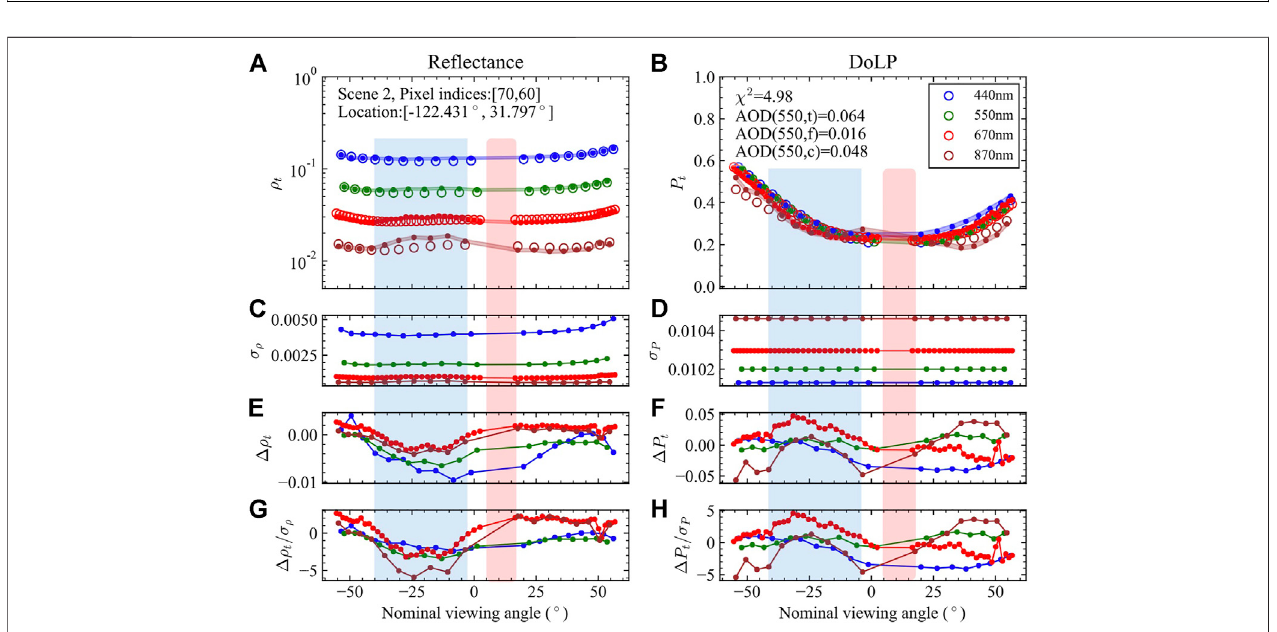
FIGURE7|(A,B) Fitted re fl ectance and DoLP (circles) and AirHARPmeasurements (dots)for apixelnear cloud Aafter the fi rst pass ofretrievals; (C,D) uncertainty model asde fi ned in Eqs 4 and 5 ; (E,F) fi ttingresiduals; (G,H) normalized fi ttingresiduals. The blue shaded region wasidenti fi edbythe datascreeningmethod ascloud- contaminated. Most DoLP measurements at 440 and 870 nm at viewing angles larger than 0 ° are also removed. Measurements within the red shaded region were removed due to water condensation on the instrument lens.